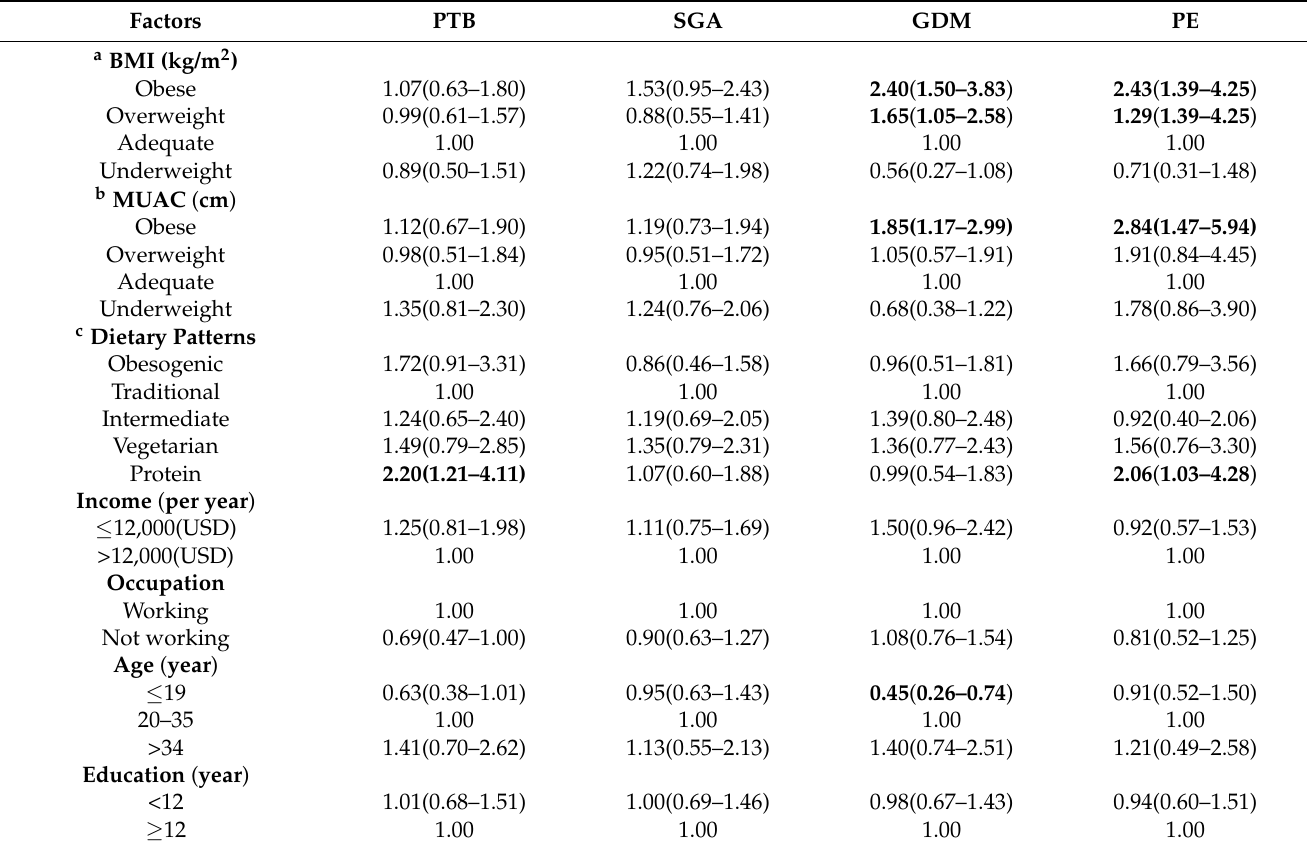
Table 2. Estimated risk of adverse gestational outcomes according to maternal sociodemographic and nutritional variables.